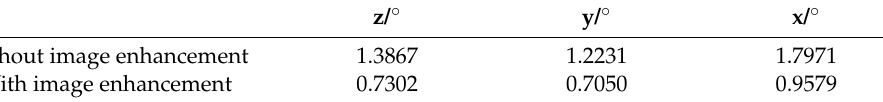
Figure 9. ISAR image enhancement results based on UNet++. Table 4. Euler angle estimation error based on swin transformer. Table 4. Euler angle estimation error based on swin transformer.